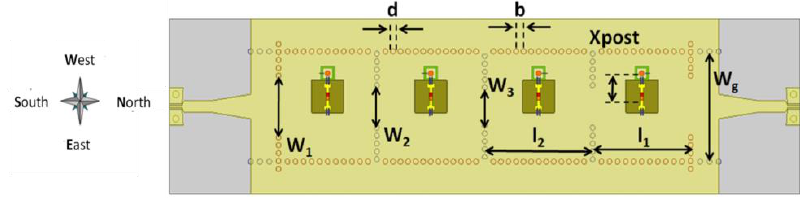
Figure 6. Layout of the tunable SIW four-pole filter. Table 2. Dimensional parameters of the filter (in mm).